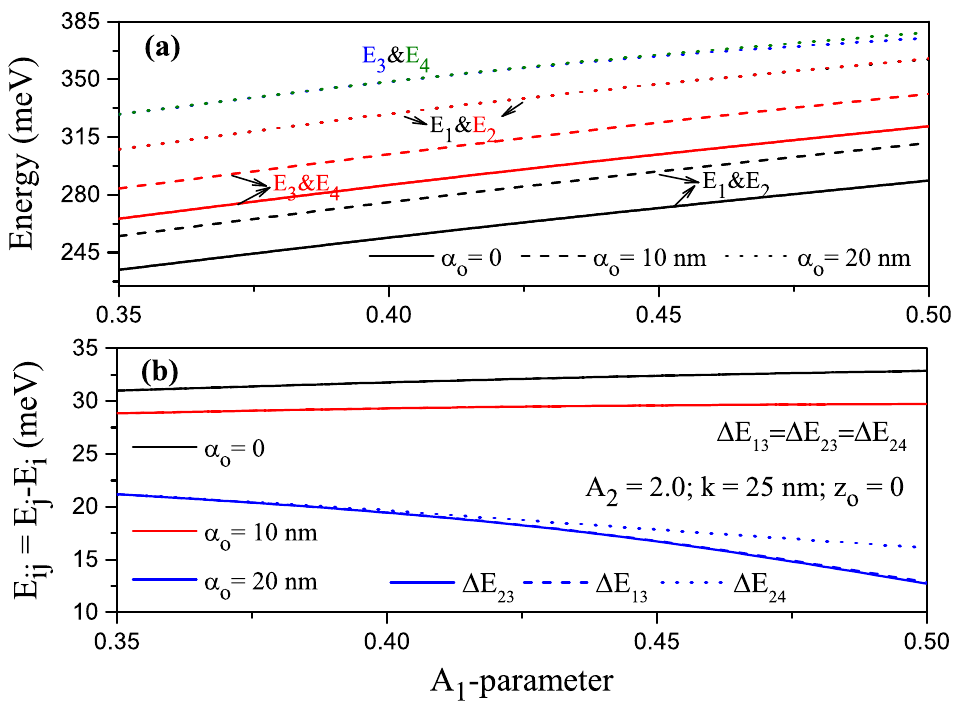
Figure 3. For k = 25nm, A 2 = 2.0, z o = 0, ( a ) changes in the energies of the electron confined within parabolic–Gaussian symmetric DQW under the intense laser field versus parameter A 1 ; ( b ) variation of energy differences between related levels versus the A 1 parameter. Solid, dashed, and dotted curves are for α o = 0, α o = 10nm, and α o = 20nm, respectively.